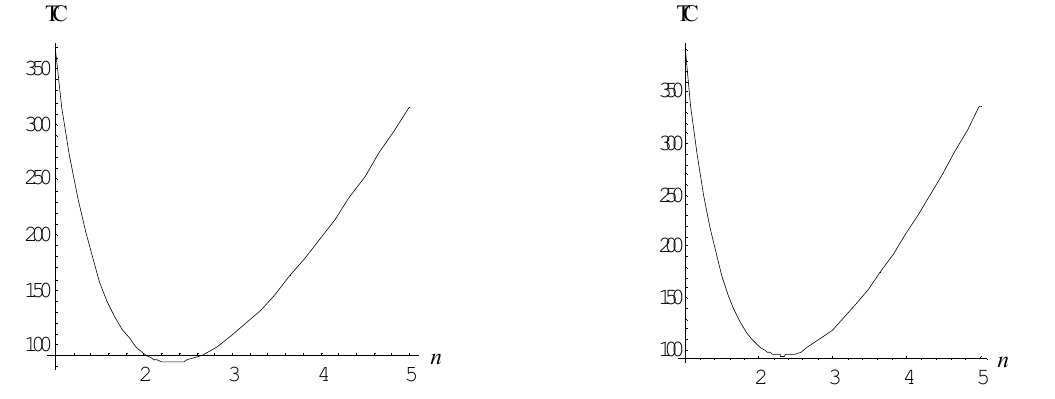
Fig 8.(a) The effect of parameter n on the total cost in the crisp model